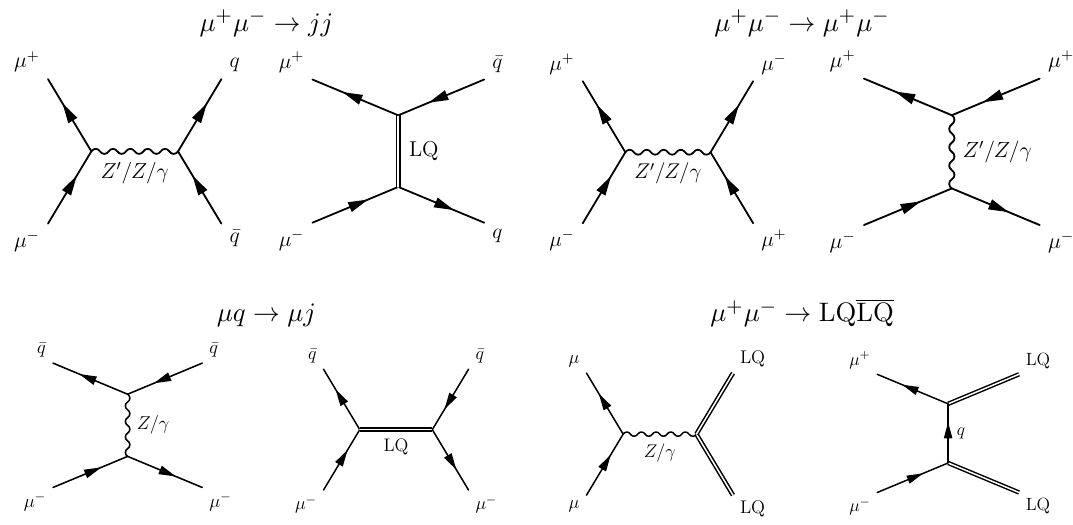
Figure 1 . Feynman diagrams for the partonic processes relevant for our MuC phenomenology. For the scalar leptoquark S 3 one should exchange q ↔ ¯ q .